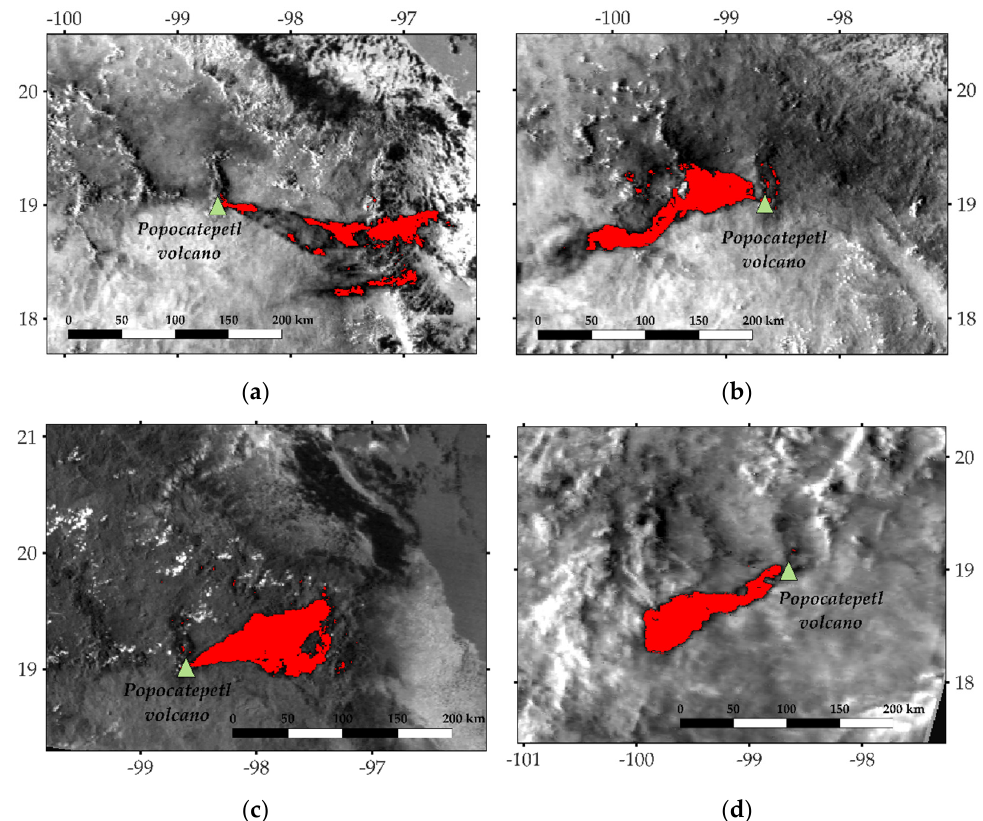
Figure 7. Volcanic ash clouds from Popocatepetl volcano identified in the MODIS image by BTD technique. Pixels with negative values that indicate the presence of volcanic ash are identified in red. ( a ) 18 April 2012 [Terra, 16:55 UTC]. Volcanic ash cloud 5 h after the eruption started. ( b ) 4 May 2012 [Terra, 16:55 UTC]. Volcanic ash cloud 13 h after the eruption started. ( c ) 7 March 2013 [Terra, 04:15 UTC]. Volcanic ash cloud 5 h after the eruption started. ( d ) 9 July 2013 [Terra, 17:50 UTC]. Volcanic ash cloud 5 h after the eruption started.